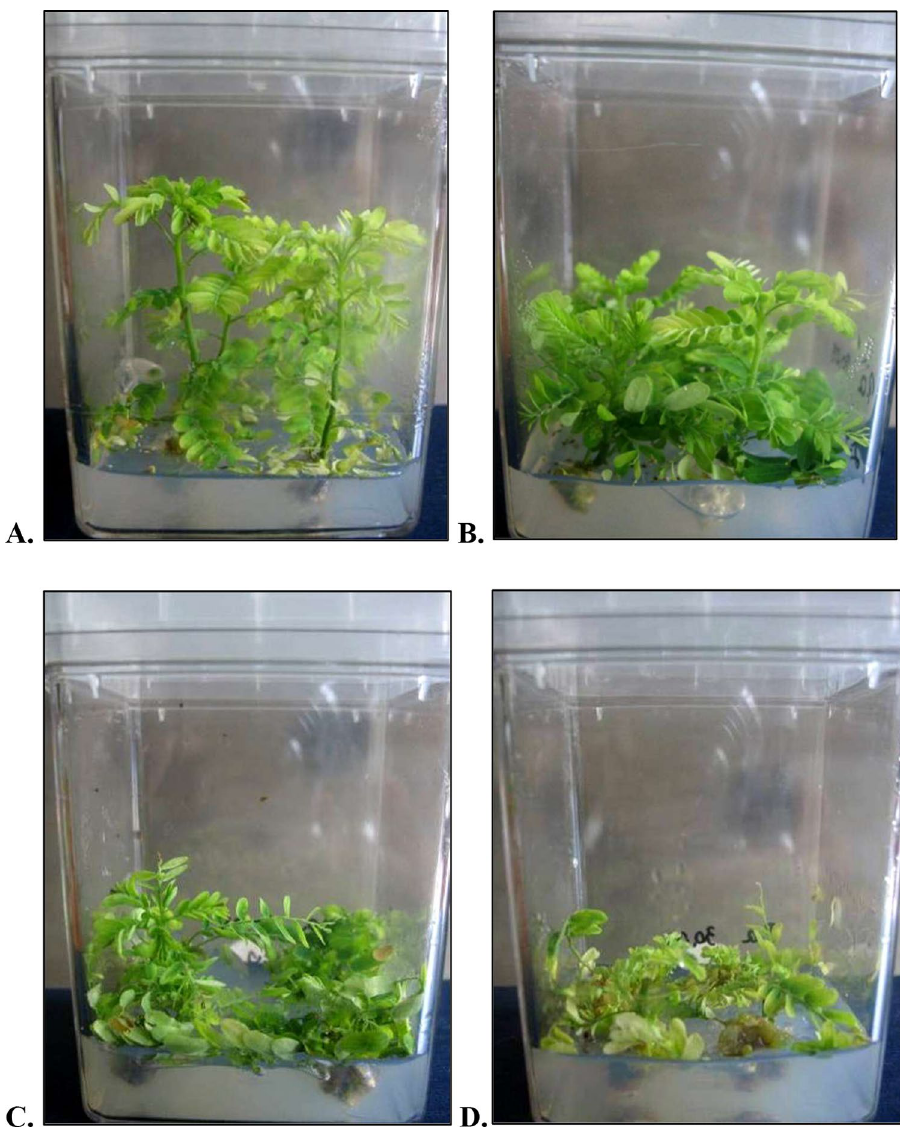
Figure 3. Shoot culture of P. amarus ( A )—MS 1.0 mg/L 2iP, ( B )—MS 1.0 mg/L Kin, ( C )—MS 1.0 mg/L BAP, ( D )—MS 0.1 mg/L TDZ